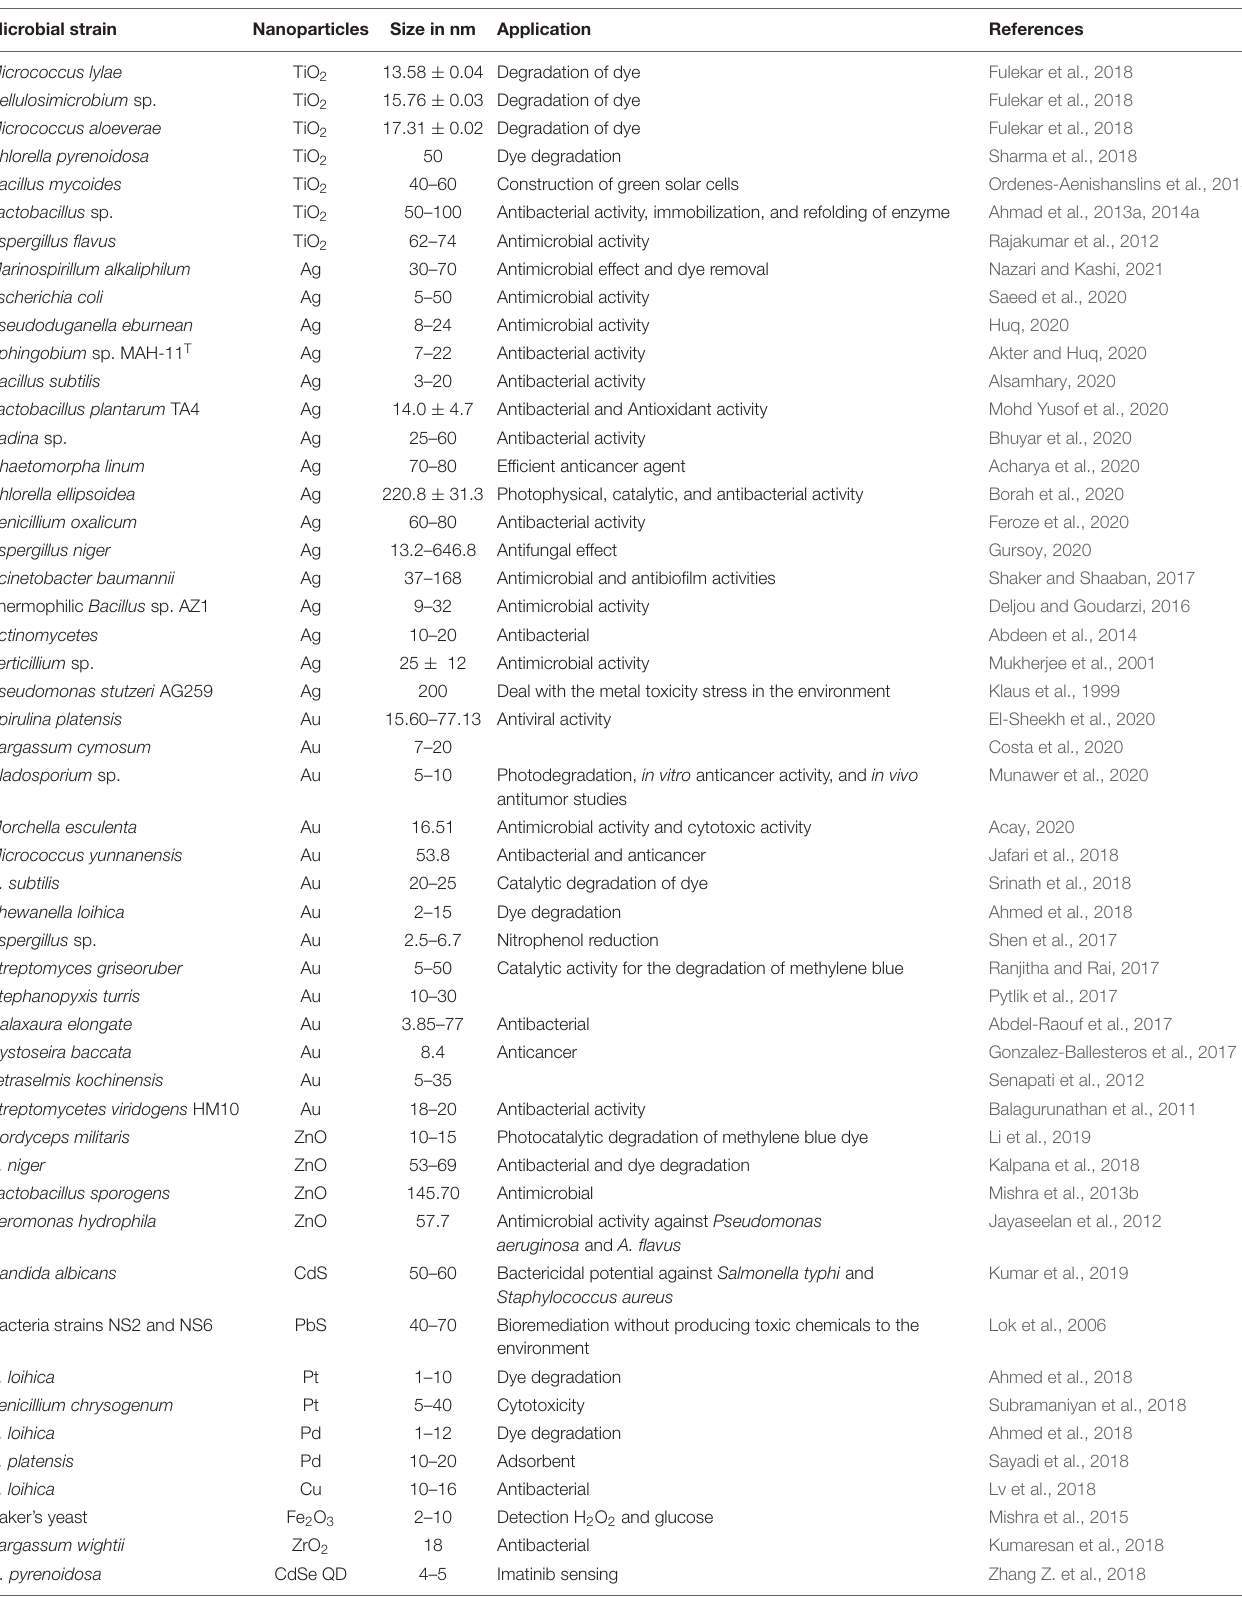
TABLE 1 | Nanoparticles synthesized by microbe and their possible